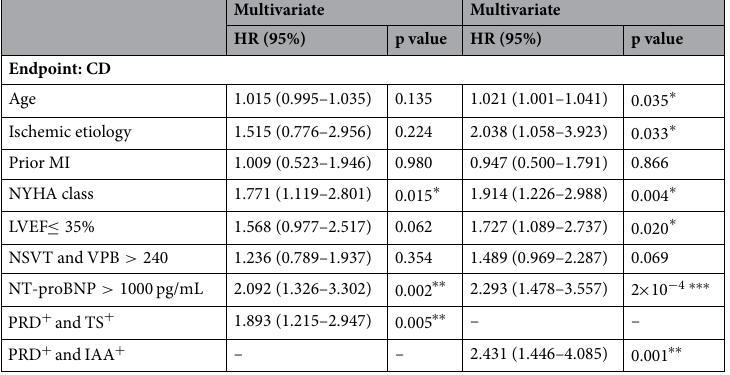
Table 8. Multivariable CD risk prediction including the following variables: age, ischemic etiology, prior myocardial infarction, NYHA class, LVEF ≤ 35% , combined NSVT and VPB > 240 , NT-proBNP > 1000pg/mL and a combined ECG variable that can be either PRD + and TS + or PRD +